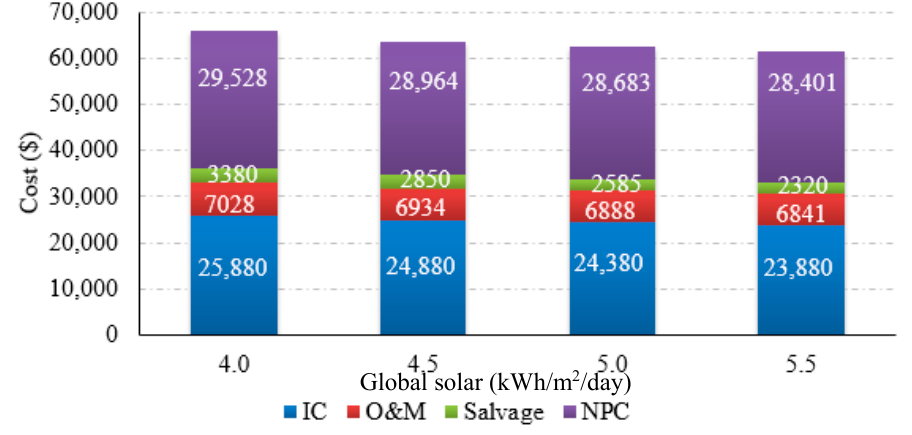
Figure 20. Summary of all costs occurring within the project lifetime for the SPV/WTG hybrid system. 7. Comparison of the Feasibility of Using a Hybrid SPV/WTG system vs. a Diesel